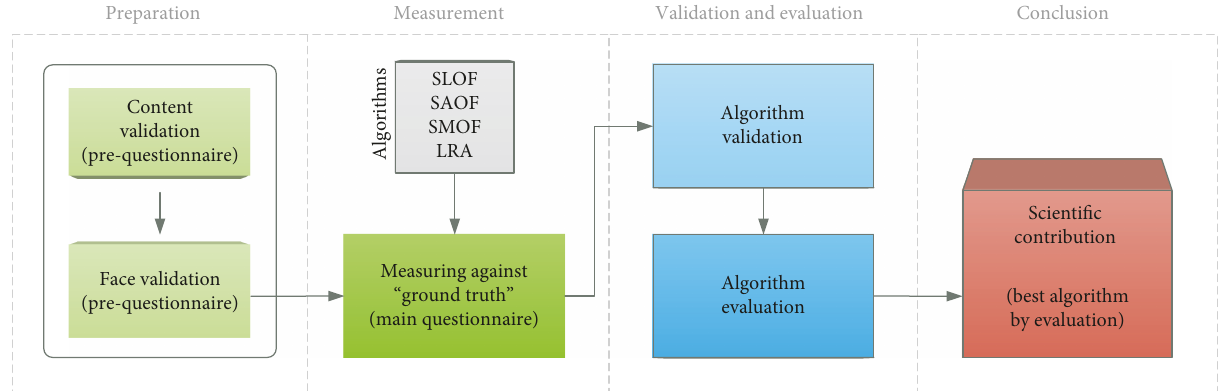
Figure 3: Proposed methodology for evaluating algorithms that calculate social in fl uence in complex social networks with its four distinct